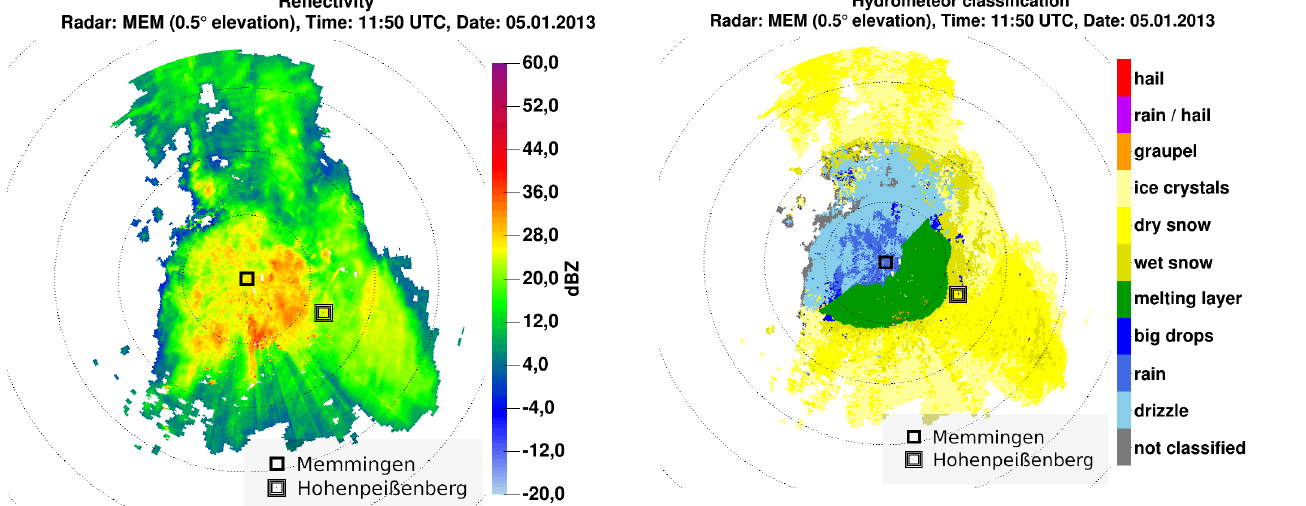
Figure 13. PPI of attenuation-corrected Z h at an elevation of 0.5 ◦ for the Memmingen radar at 11:50UTC. The location of Hohen- peißenberg is indicated.